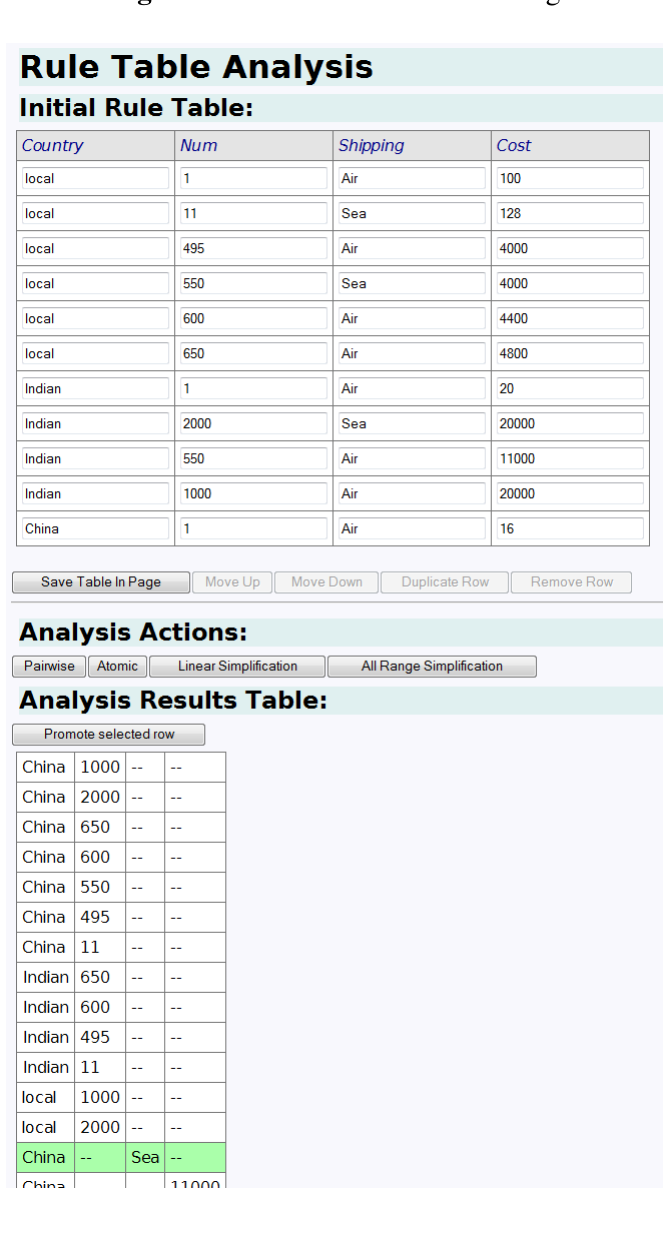
Figure 9. Business rule table